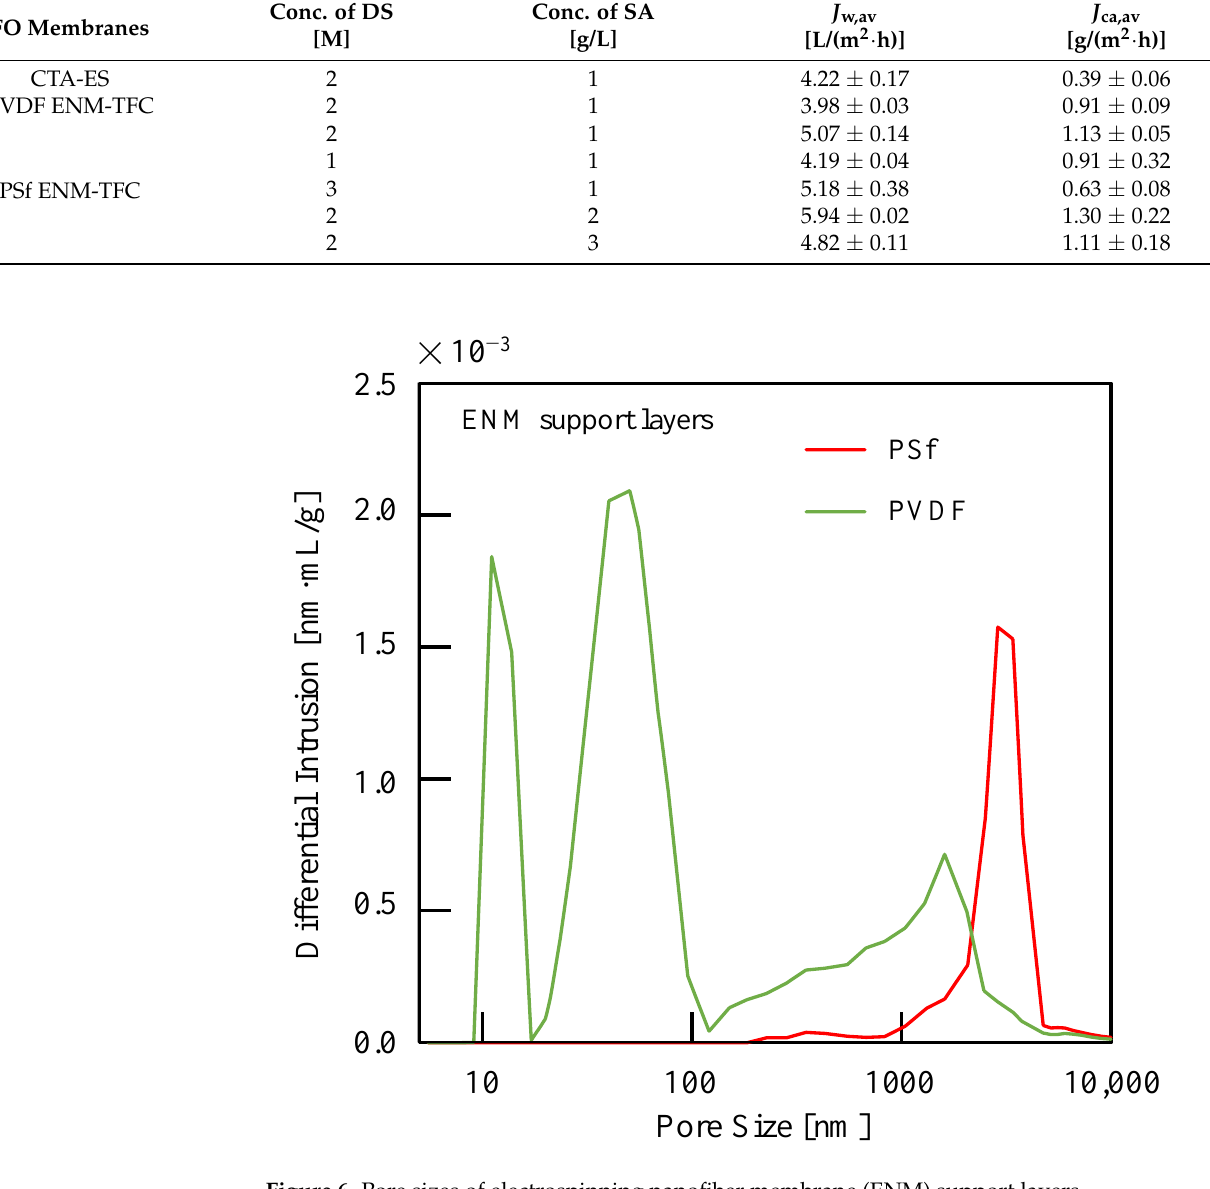
Figure 6. Pore sizes of electrospinning nanofiber membrane (ENM) support layers. Table 3. Typical parameters of the ENM support layers fabricated in this study.